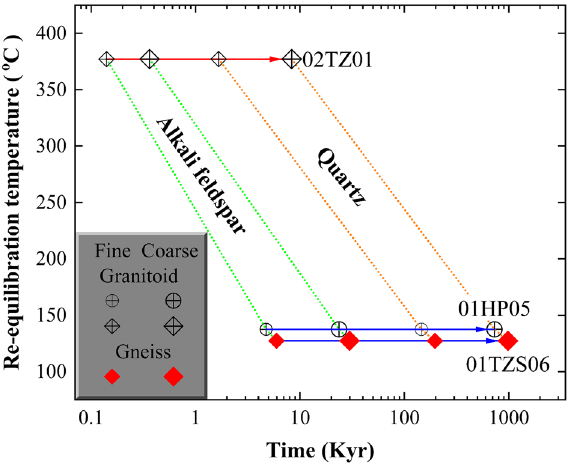
Figure 6. The relationship between time and re-equilibration temperature of fossil hydrothermal systems developed across the Dabie orogen. Symbol points denote mean values of rock-forming minerals with varied grain size sequentially re-equilibrated with the evolved magmatic (sample 02TZ01) or ancient meteoric water (samples 01HP05 and 01TZS06 in Table 2) through the surface-reaction oxygen exchange in the closed systems, respectively. Yet, error bars are almost invisible and omitted herein. Note that log10 scale of X axis is adopted for clarity, other details see